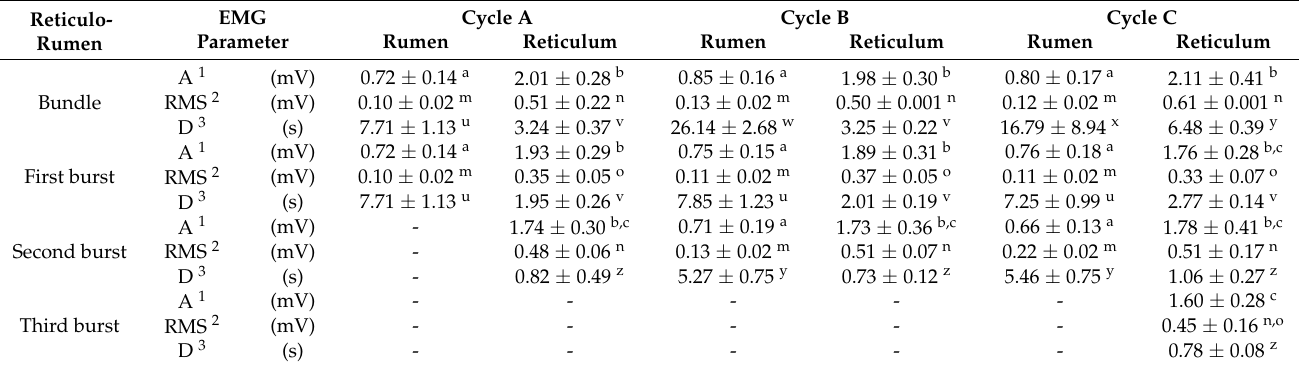
Table 1. The electromyography (EMG) signal parameters (mean ± SD) in the reticulo-rumen during cycles A, B, and C registered in sheep ( n = 9) during 3 h daily recording session.